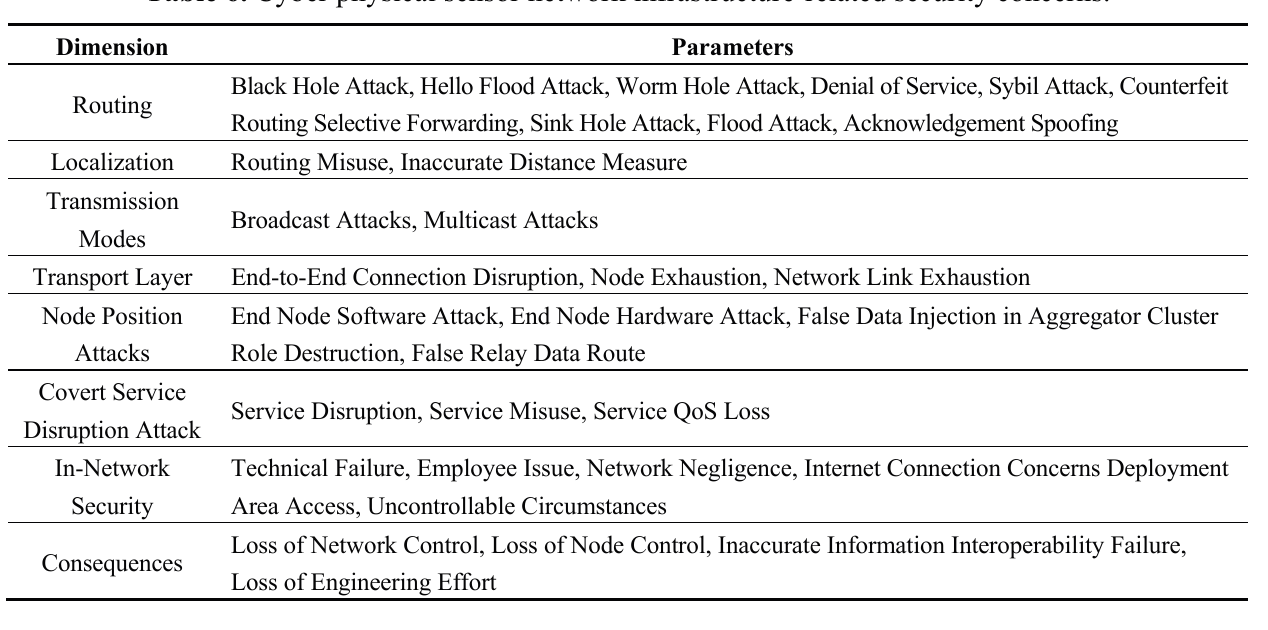
Table 6. Cyber physical sensor network infrastructure-related security